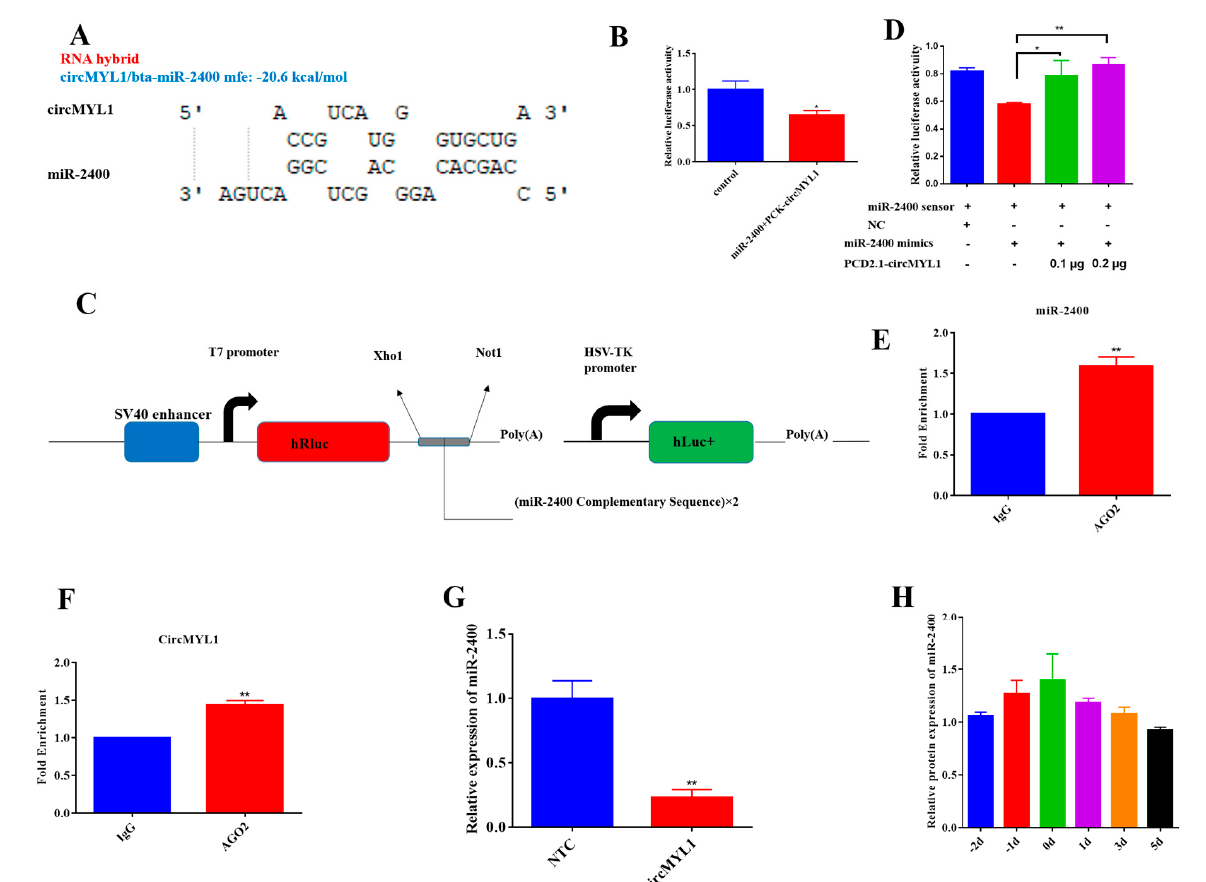
Figure 5. circMYL1 acts as a miR-2400 sponge ( A ) RNAhybrid predicted the potential binding sites of miR-2400 on the circMYL1 sequence. ( B ) Luciferase assay was conducted after co-transfection of the HEK293T cells with miR-2400 mimic and PCK-circMYL1. ( C ) A schematic drawing for the structure of the miR-2400 sensor. ( D ) Luciferase assay was conducted after co-transfected the miR-2400 sensor into HEK293 T cells with the miR-2400 mimic and/or PCD2.1-circMYL1. ( E ) AGO2 RNA immunoprecipitation (RIP) assay detected the fold enrichment of miR-2400 in bovine primary myoblasts. ( F ) AGO2 RNA immunoprecipitation (RIP) assay detected the fold enrichment of circMYL1 in bovine primary myoblasts. ( G ) qRT-PCR detected the relative expression levels of miR-2400 after overexpression of the circMYL1. ( H ) miR-2400 expression level during proliferation and differentiation of bovine primary myoblasts. Data are shown as mean ± SEM. n = 3. * p < 0.05; ** p <